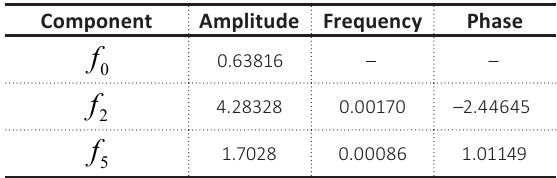
Table 1. Fourier components